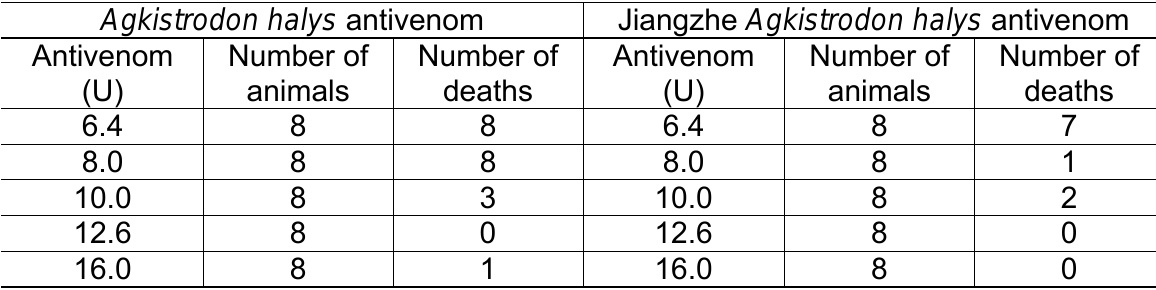
Table 4.1: Anti-lethal toxin effective dose (ED Agkistrodon halys antivenoms against 115.4 µg Agkistrodon halys venom (4 x LD intravenously injected into mice.